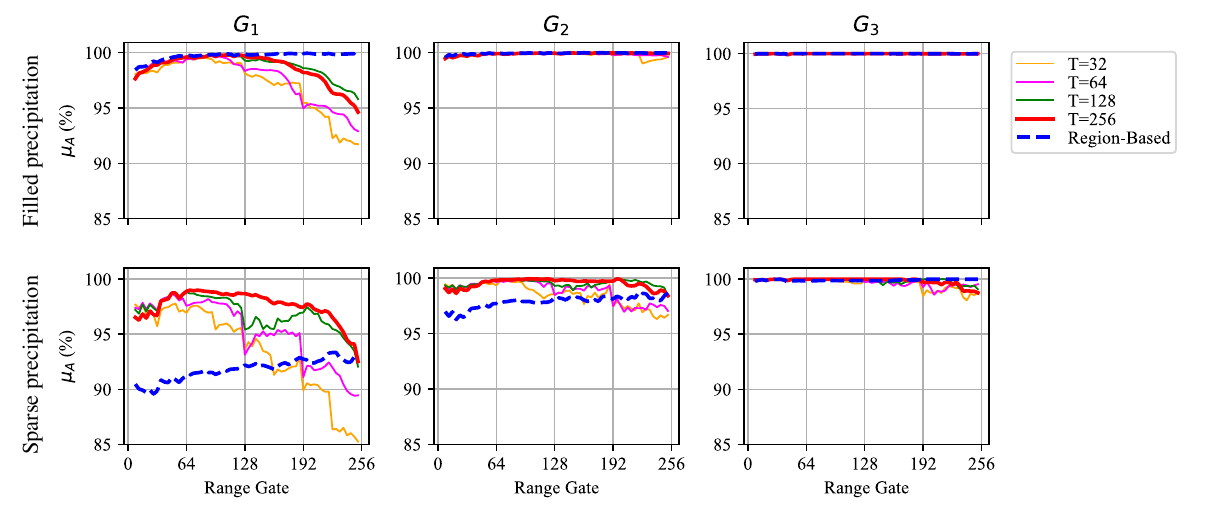
Figure 10. Performance of the CNN algorithm as a function of range with the different T , i.e., 32 (or- ange), 64 (magenta), 128 (green), and 256 (red) range gates. It is also compared to the conventional region-based dealiasing method (blue dashed line). The first row is µ A in percentage averaged by the number of scans for the mostly filled precipitation. The second row is also the µ A but for the sparsely filled precipitation scans. It is analyzed with groups G 1 ( left ), G 2 ( center ), and G 3 ( right ).